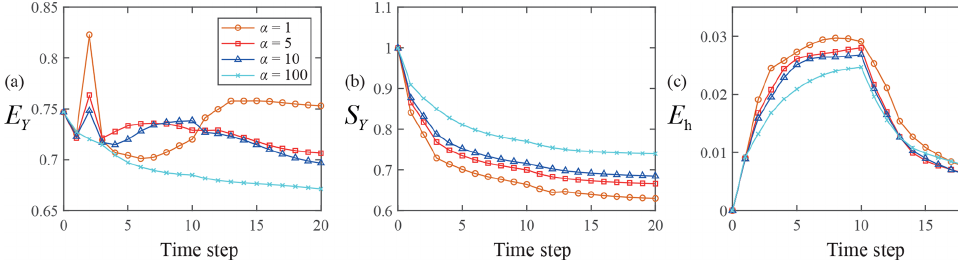
Figure 11. Temporal evolution of E Y (a) , S Y (b) , and E h (c) with α = 1 (TC3), 5 (TC3 α 1 ), 10 (TC3 α 2 ), and 100 (TC3 α 3